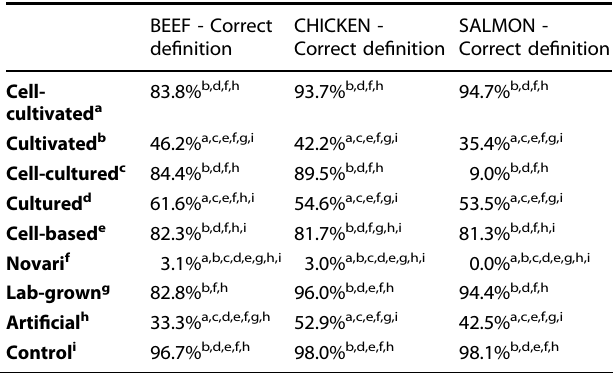
Table 4. Pairwise comparisons between names on the percentage choosing the correct de fi